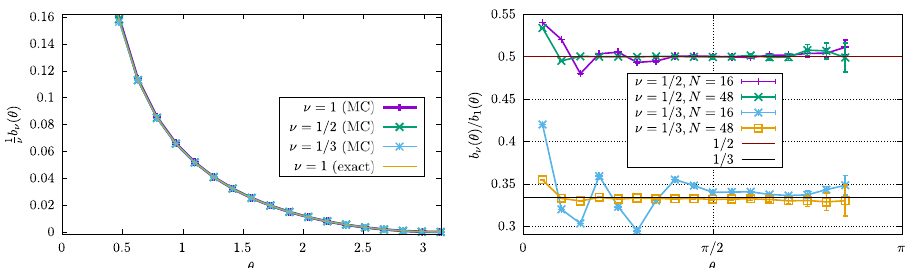
Fig. 2 Charge fl uctuations in fractional quantum Hall states. Monte Carlo (MC) extraction of the corner term b ν for several fi lling fractions ν . Left: ν − 1 b ν ( θ ) for N = 48 particles and fi lling fractions ν = 1, 1/2, 1/3. The collapse onto a single curve is nearly perfect. Right: Illustration of the fi nite-size effects for ν = 1/2, 1/3, by plotting b ν ( θ )/ b 1 ( θ ) for an increasing number of particles. The curves become constant for large N . The slight discrepancy for small θ is a fi nite size effect: for such small angles, there are very few particles in A , unless N is extremely large. Note also the increase of the error bars when